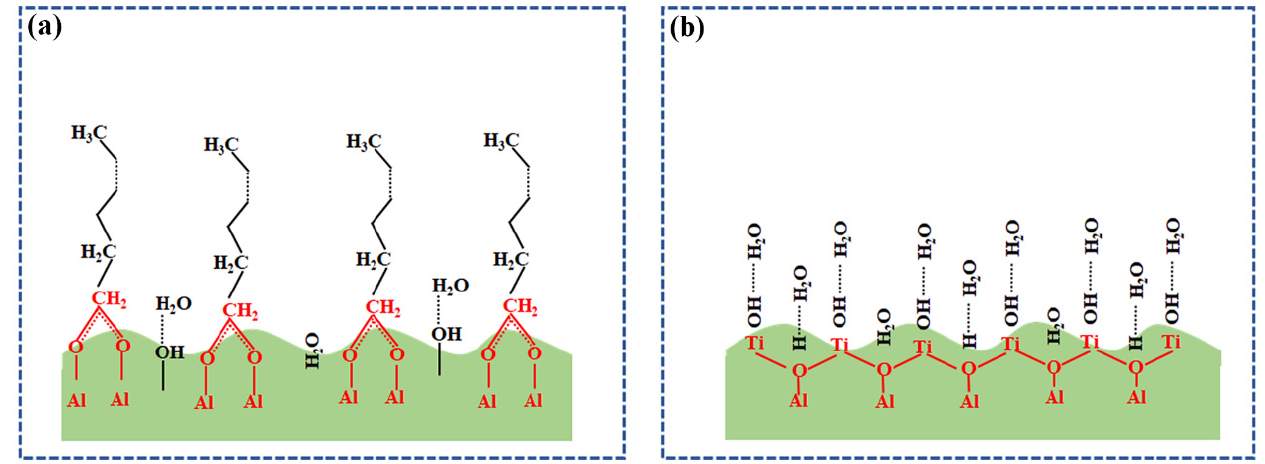
Figure 2. Schematic diagram for depiction of the superhydrophilic evolvement on the sapphire surface under different conditions. ( a ) Chemisorption of non-polar saturated hydrocarbon chains on the laser-treated surface to make the superhydrophilic persistence shorted and conversion into the hydrophobicity; ( b ) Coordination of metal ions on the laser-structured sapphire surface by TiO 2 varnish to allow the adsorption of hydrophilic group for extending the superhydrophilic durability.